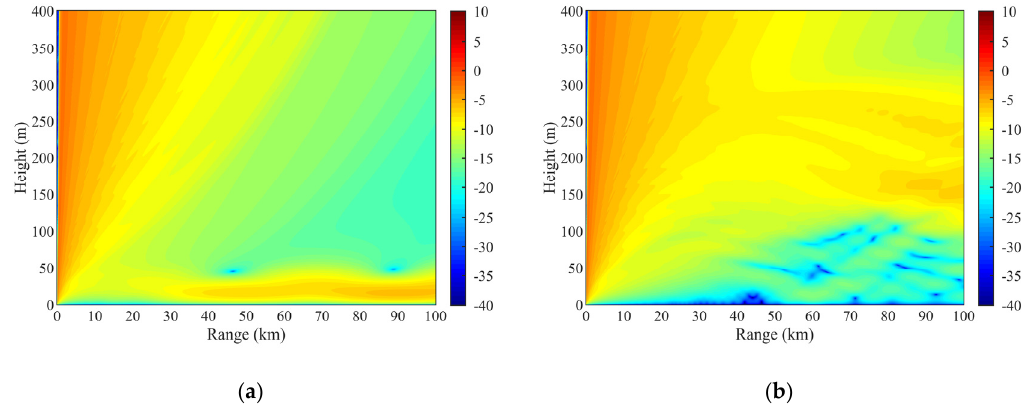
Figure 7. Received powers versus the horizontal distance in standard atmosphere, horizontally homogeneous and inhomogeneous surface ducts for ocean-scattered B1I signals. 3. Estimation of the Regional Distribution of Tropospheric Ducts The WRF [54] model is a numerical weather prediction and atmospheric simulation system designed for both research and operational applications, including real-time NWP, data assimilation, regional climate simulations, etc. Since the WRF model is a new, fully open, portable, and updated fast mesoscale model, domestic and foreign researchers have adopted it into meteorological research frequently. Based on the WRF model, we can make a rough estimate of the regional distribution of tropospheric ducts. The more accurate estimation of duct parameters requires other methods, such as the RFC method. In the